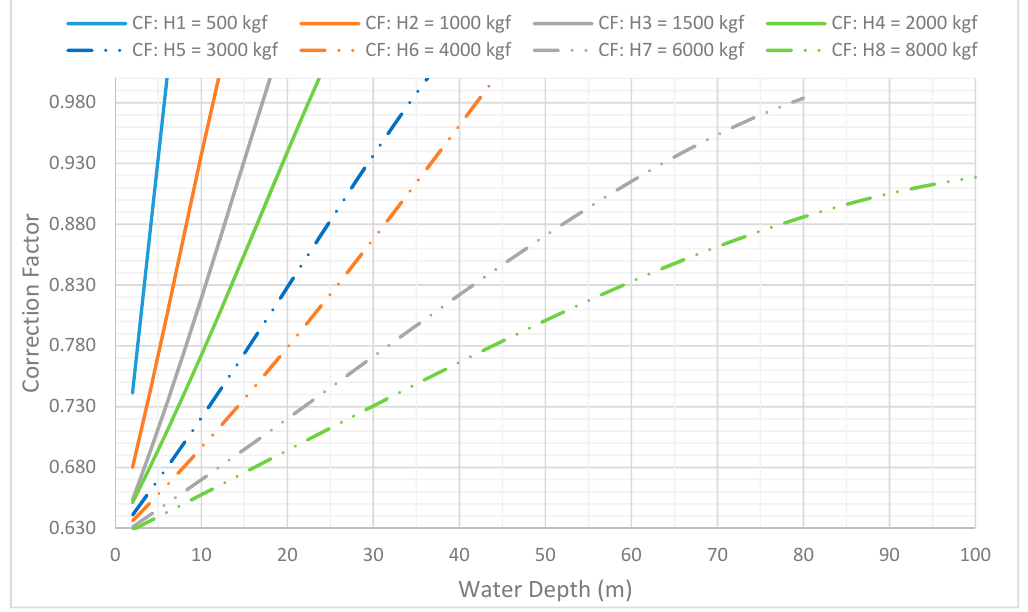
Figure 17. Multiplying correction factors (CF) for application to the original results for the calculation of the MBR for various deployment cases.